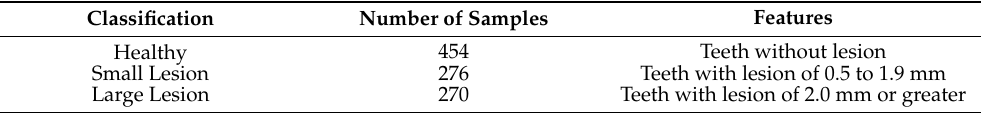
Table 2. Summary of the used dataset.